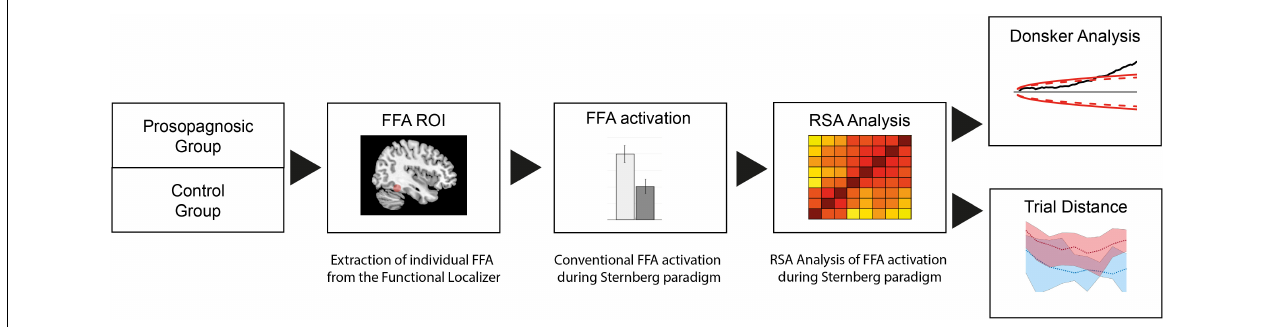
FIGURE 2 | Flow chart of fMRI analysis process: The FFA region is derived from a functional localizer and conventional FFA activation during the Sternberg paradigm extracted. For analysis on voxel-wise level, RSA with a Donsker’s random walk analysis is performed.